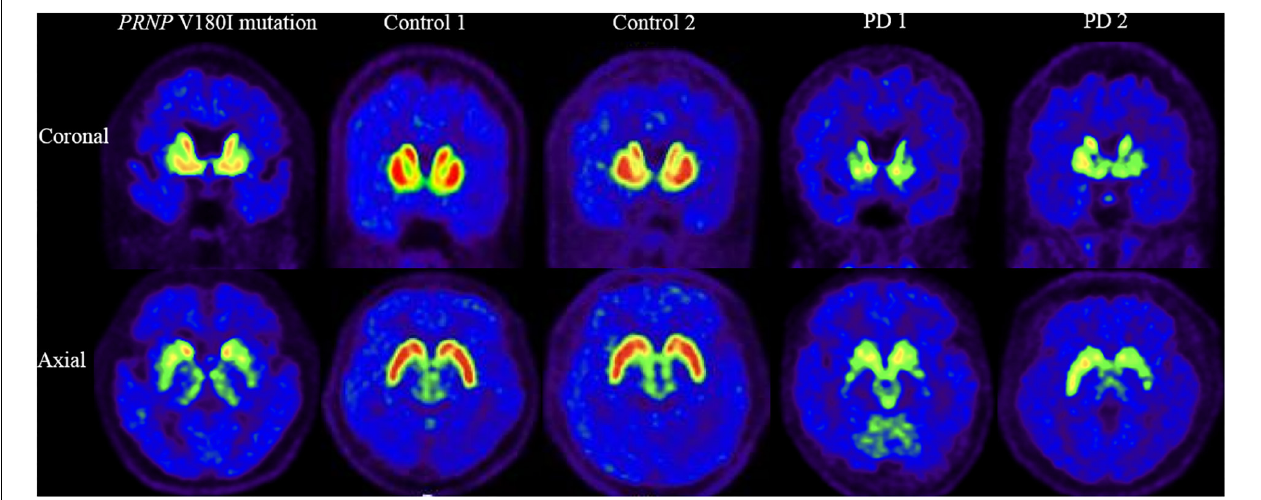
FIGURE 2 | [ 18 F]-DTBZ-PET/CT imaging of the VMAT2 distribution in patient with PRNP V180I mutation and controls/cases with PD. The same slice is presented for the case and two controls and two cases with PD. This patient with PRNP V180I mutation has obvious symmetric dopamine decline of the bilateral putamen, predominantly in the posterior part. While Controls 1 and 2 have normal dopamine metabolism, asymmetric decline of vesicular transporter availability with a posterior-to-anterior gradient can be seen in PD 1 and PD 2.